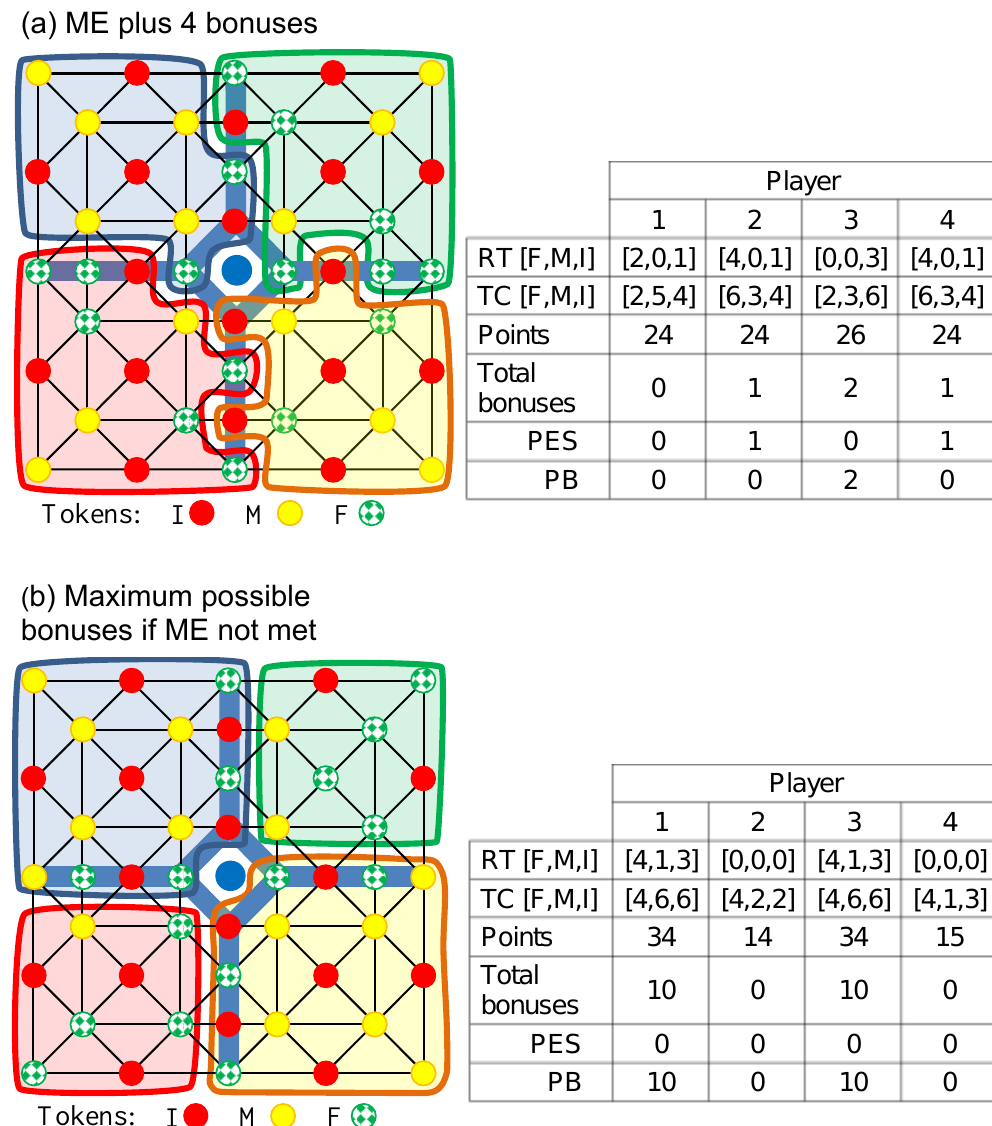
Fig. 2. Schematic diagrams of the SS game board, showing results that give the maximum possible number of bonuses for the group of four players under two different conditions: (a) Obligatory ME, and (b) no obligation to achieve ME. Lines drawn around each quadrant enclose the tokens placed by each player. In (b), players 1 and 3 have been ceded control of all of the riparian sites that are available to them. RT = The set of tokens that the player has placed on riparian sites. (Format is [<number of F tokens>, <number of Ms>, <number of Is>].) CT = The complete set of tokens that the player has used. (Format is the same as for RTs.) Total Bonuses = sum of PES and PB. PB =Provision Bonus (equal to the number of points earned in excess of the 24 needed for survival). (Note that (b) is not an outcome because it does not give 24 points to each